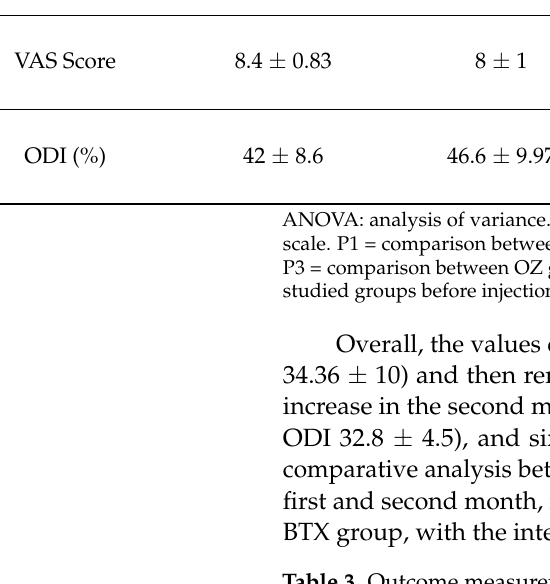
Table 3. Outcome measurement (1-, 2-, 3-, and 6-months post-injection) of the three studied